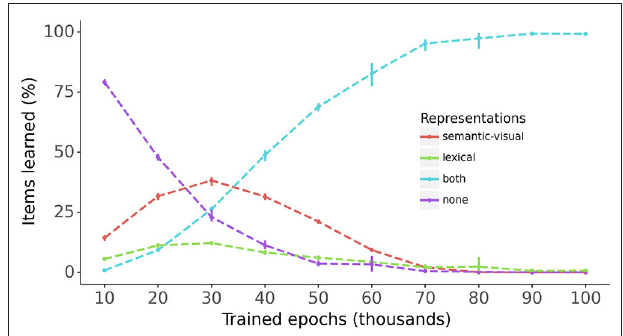
FIGURE 5 | The progress of learning of the semantic-visual and lexical representations across all models. Bars: 95 % confidence